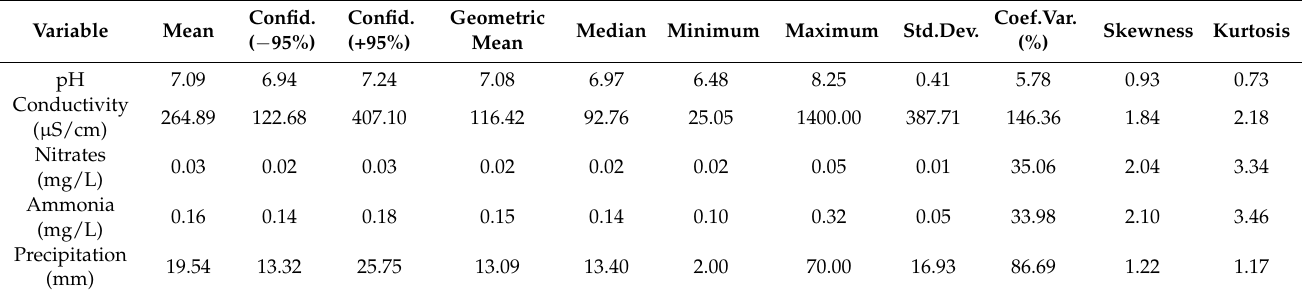
Table 1. Summary statistics for the monitored period (n = 31).